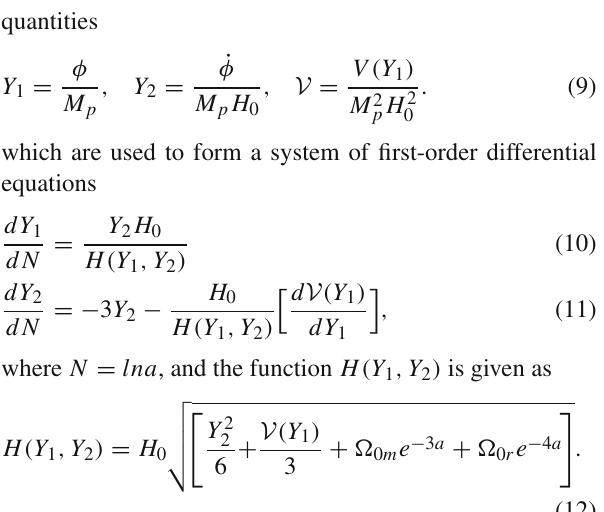
Fig. 3 This figure corresponds to potential (1) with n > 1 and differ- ent values of α . The left and middle panels show the evolution of ρ φ , ρ ρ w(φ) and w m , r , ef f versus z . Both panels are obtained for n α = 4 (solid), n = 2, α = 6 (dotted), n = 3, α = 4 (dot-dashed) and